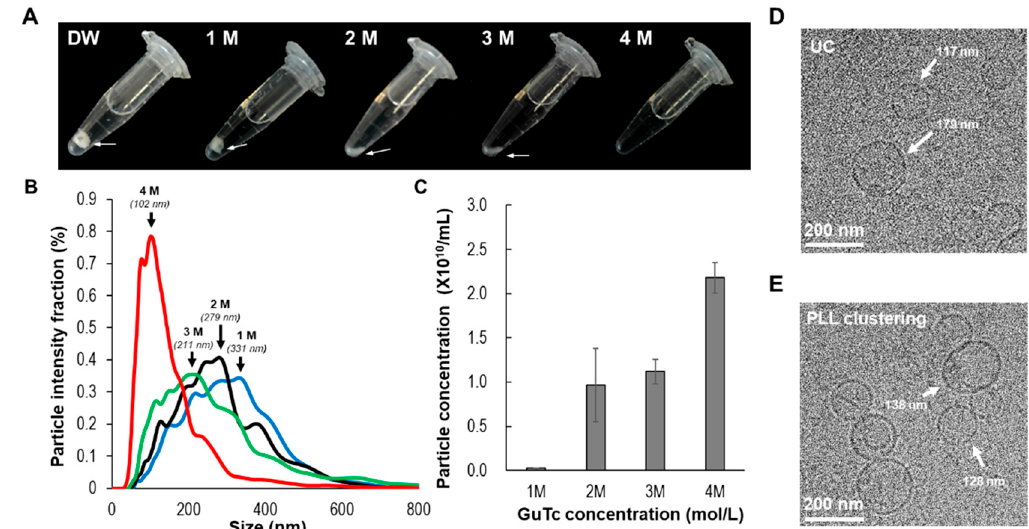
Figure 3. Resuspension of EV cluster in GuTc buffer. ( A ) Serial images of resuspension of EV cluster according to GuTc concentration. PLL was fixed at 0.2 mg/mL and GuTc concentration was varied from 0 to 4 M. ( B ) Effect of GuTc concentration during elution according to particle size (black arrows indicate peak size) and ( C ) concentration analyzed using NTA. Cryo-TEM images of EVs isolated by ( D ) UC and ( E ) PLL (0.2 mg/mL) and GuTc (4 M). (PLL: poly-l-lysine, GuTc: guanidium thiocyanate).